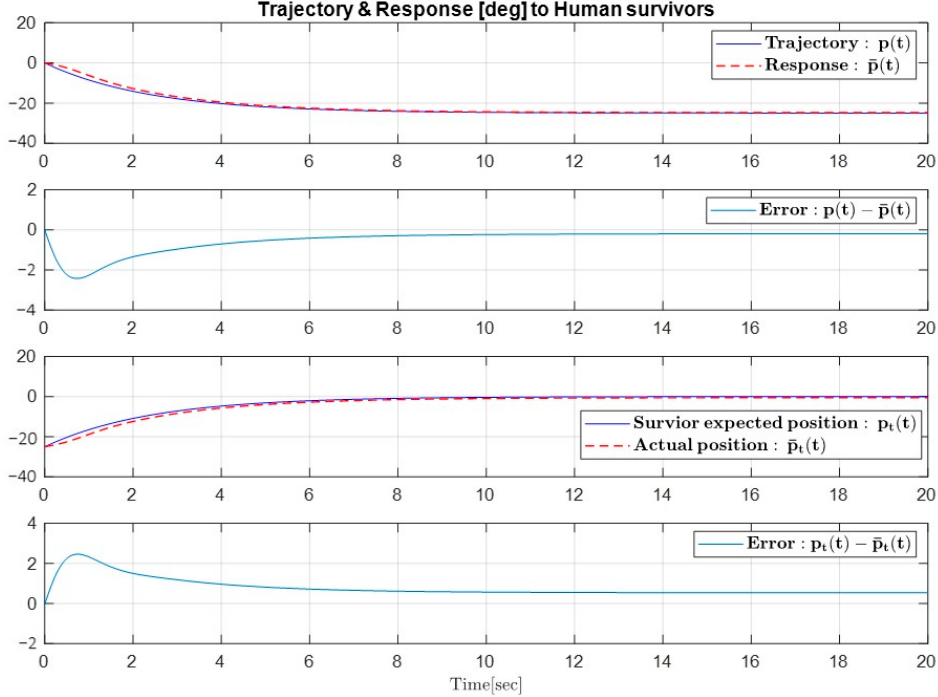
Figure 19. Experiential results of Case II: target trajectory vs. resulting trajectory and target orientation vs. resulting orientation.